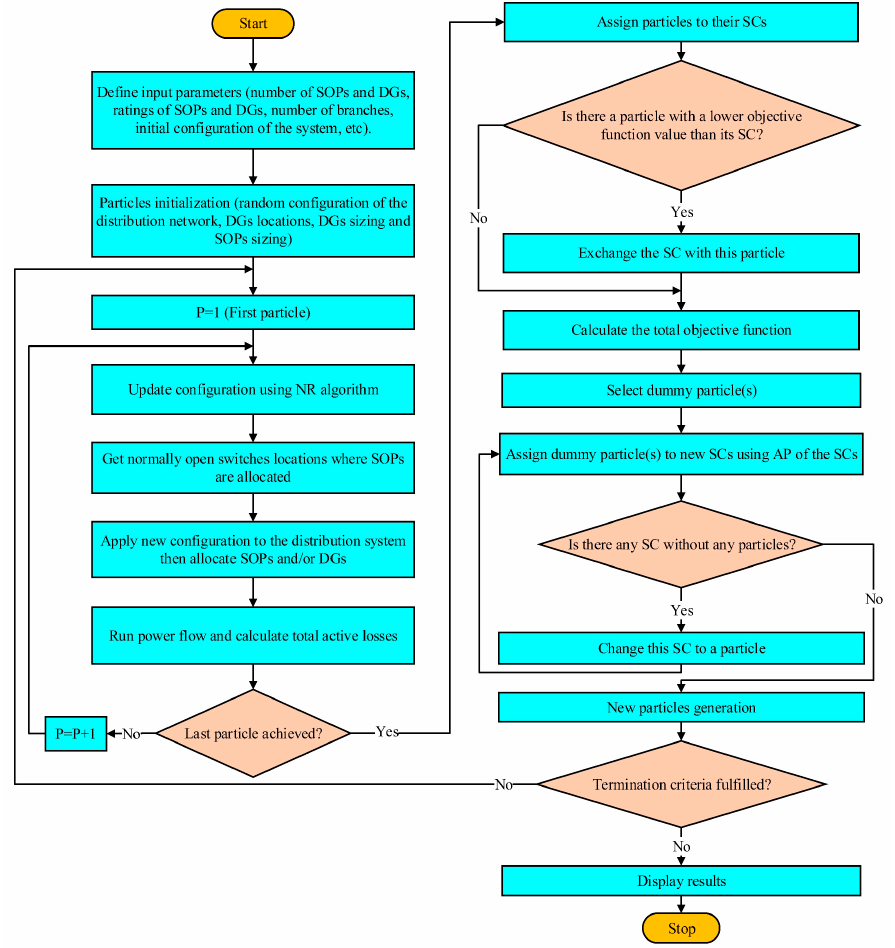
Figure 2. A comprehensive flowchart for the proposed problem formulation using the DC-HSS algorithm.